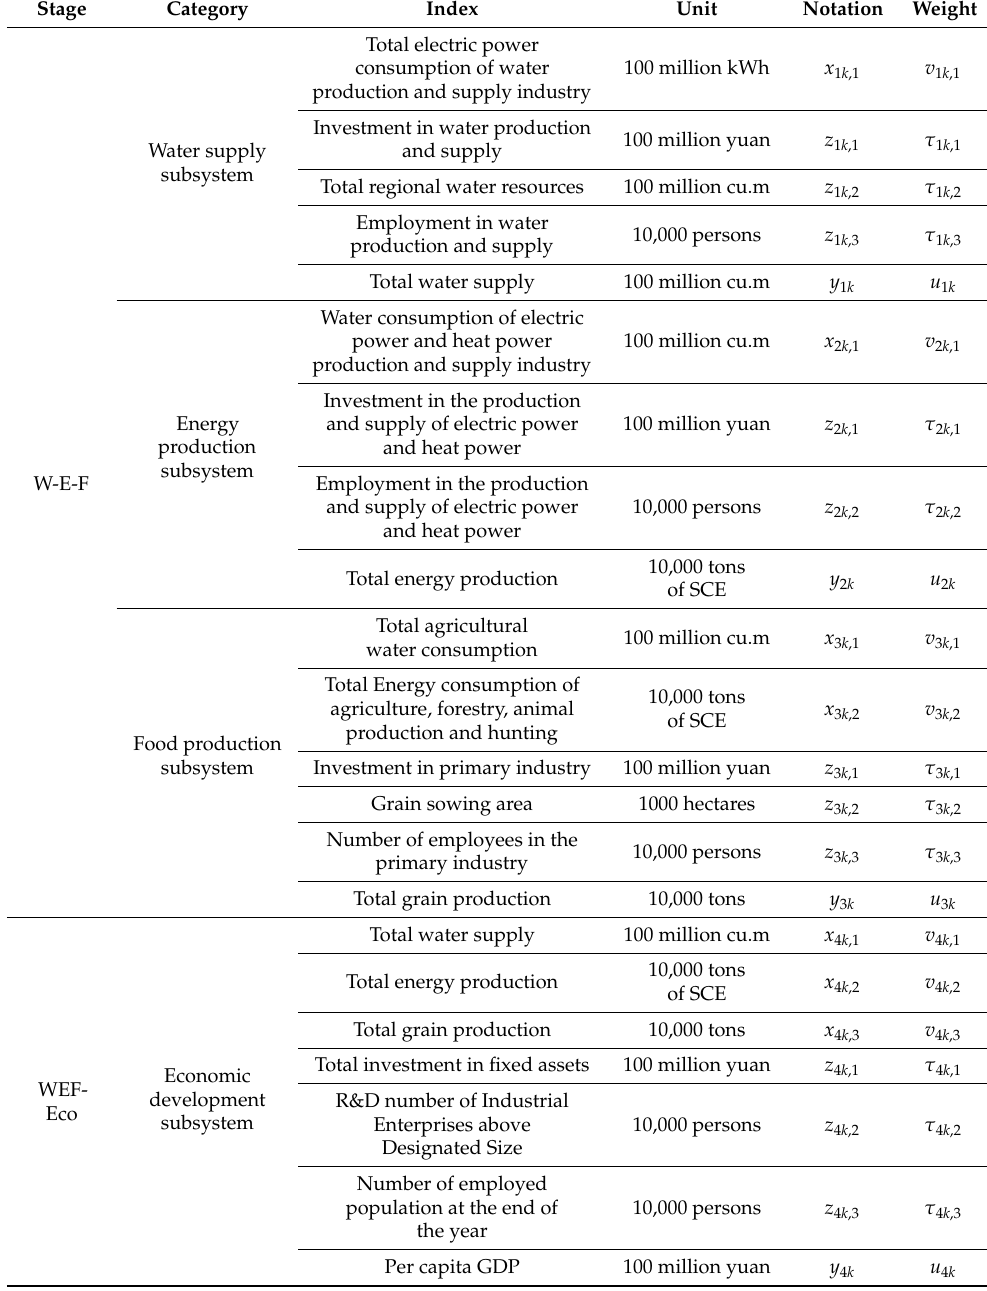
Table 2. Efficiency evaluation index system of the WEF-Eco